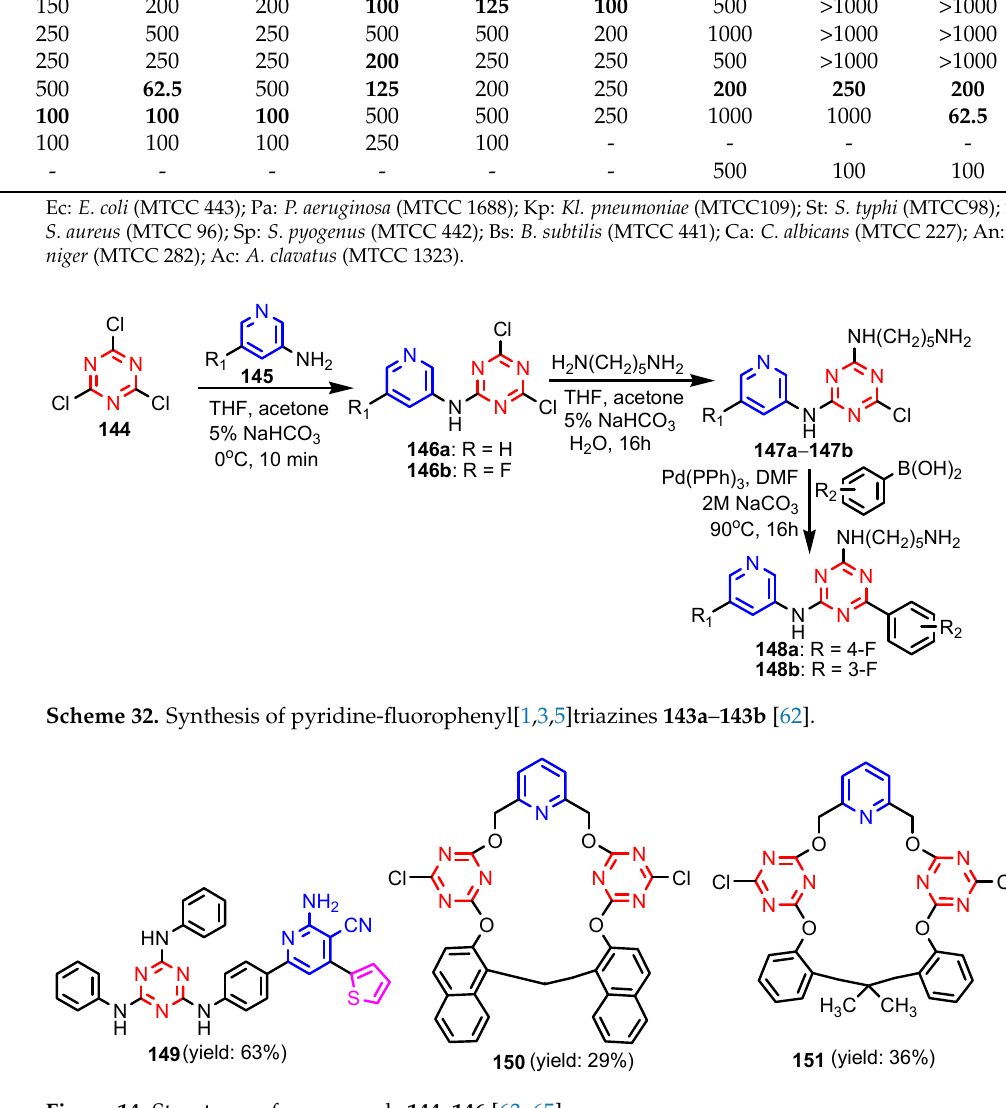
Figure 14. Structures of compounds 144–146 [63–65].